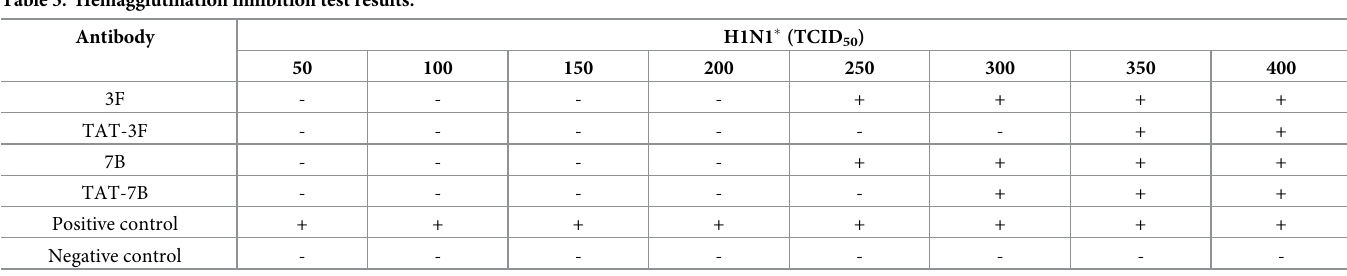
Table 3. Hemagglutination inhibition test results.